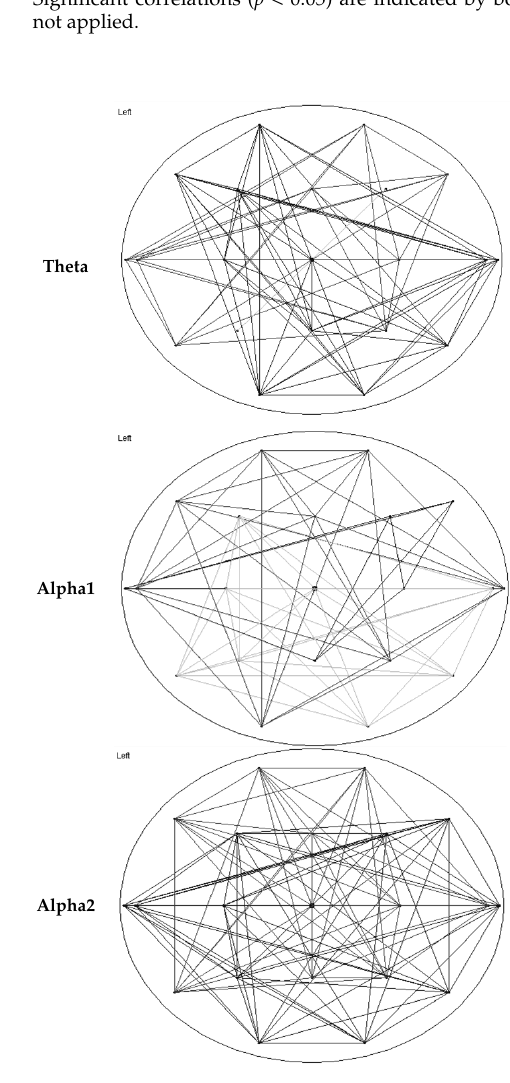
Figure 1. Average network maps for all patients for the theta, alpha1, and alpha2 frequency bands. The maps demonstrate the presence of correlations between pairs of channels, with threshold of 0.1 (PLI value) or correlations above that